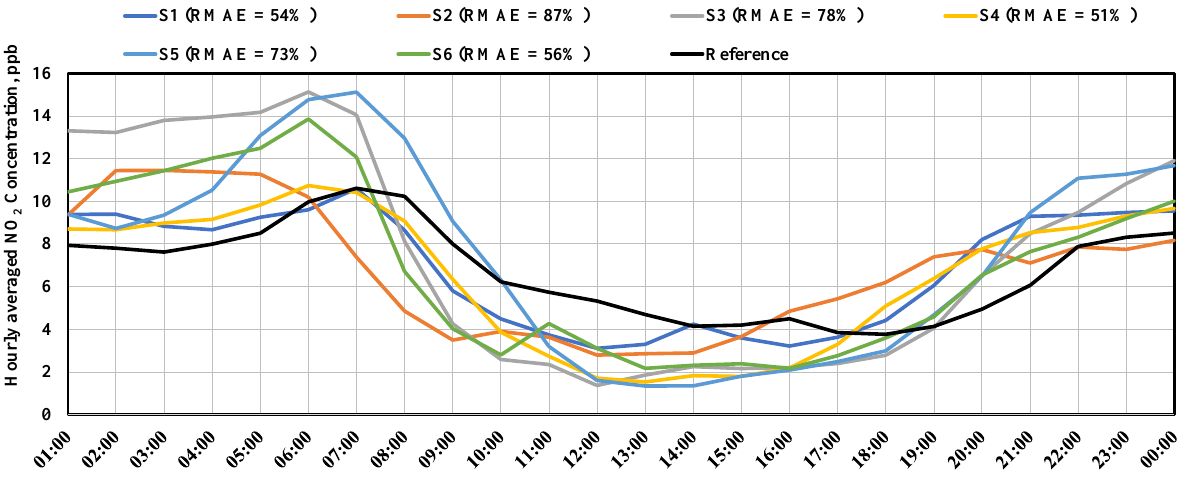
Figure 6. Hourly averaged NO 2 concentrations based on AirSENCE™ and reference measurements for weekdays in the month of August 2019 in the GTA Satellite Smart City, Ontario. Relative mean absolute errors are indicated for each AirSENCE™